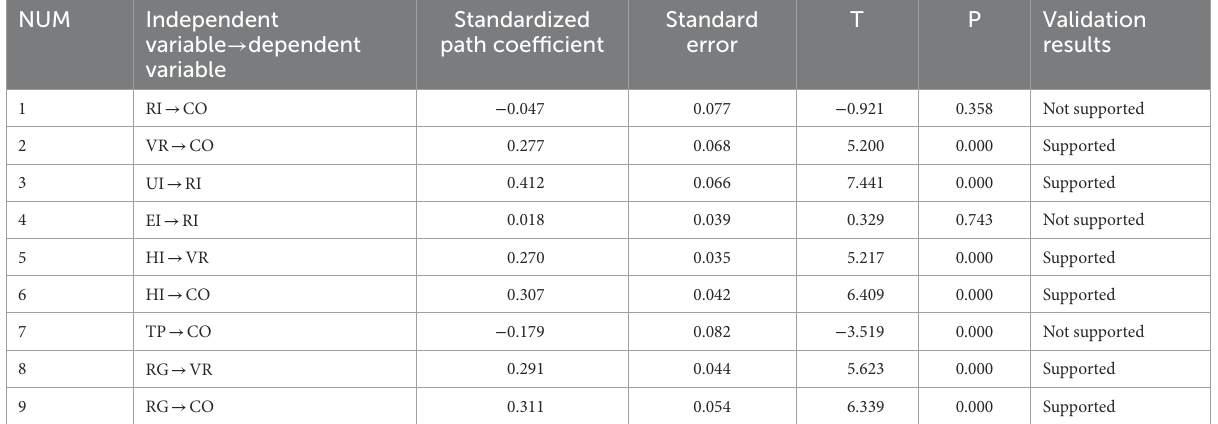
TABLE 8 Path coefficients and hypothesis testing